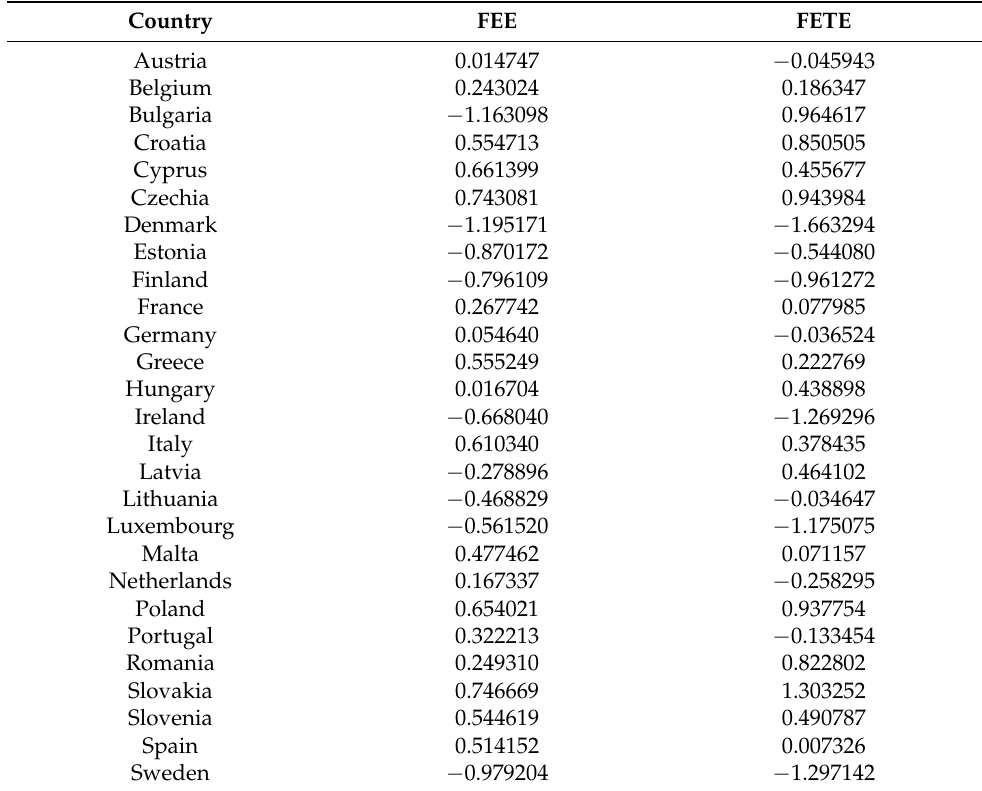
Table 7. Estimated entity effects for the FEE and FETE models.